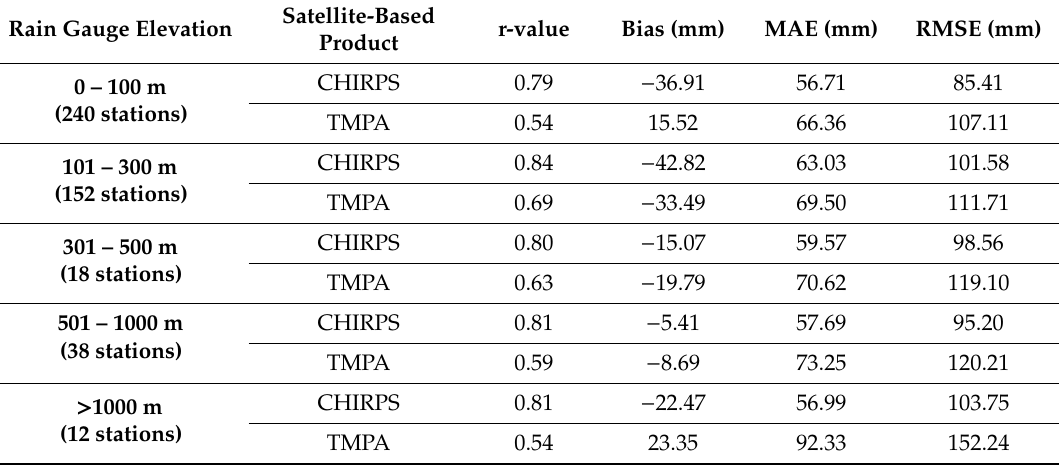
Table 3. Comparison statistic results between rain gauge measurements and satellite-based precipitation estimates for monthly rainfall categorized on the basis of elevation for R, bias, MAE, and